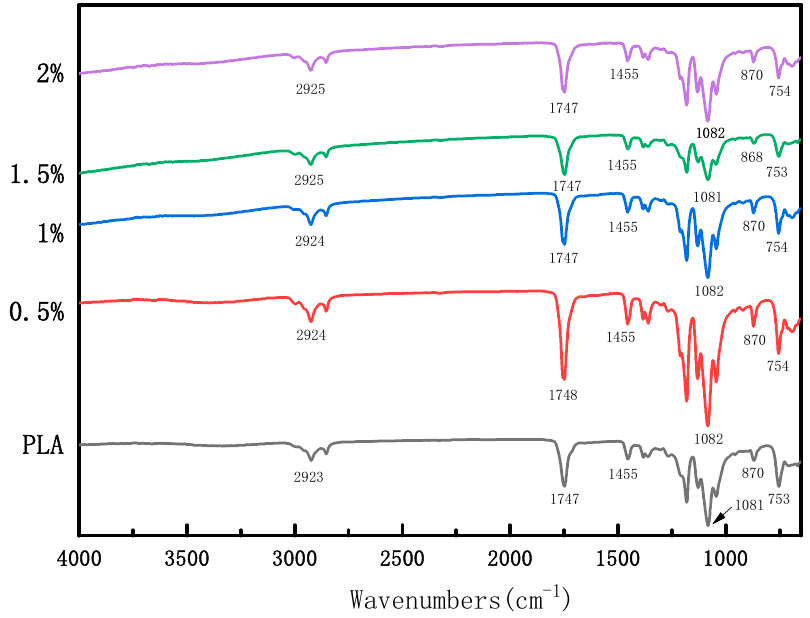
Figure 3. FTIR spectra of pure PLA and PLA/SeMPs membranes with different SeMPs weight ratios.